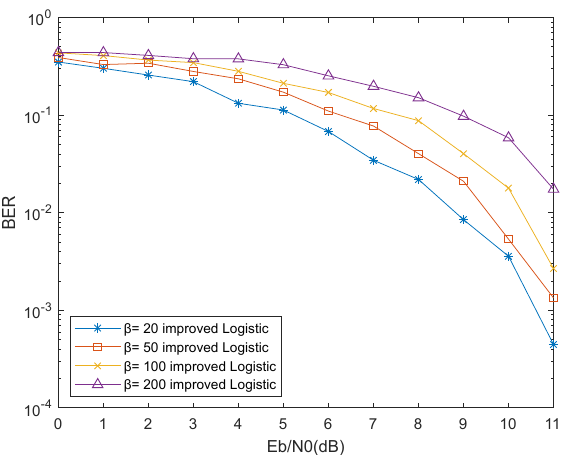
Figure 10. BER curves of the system with different semi − spread spectrum factors.